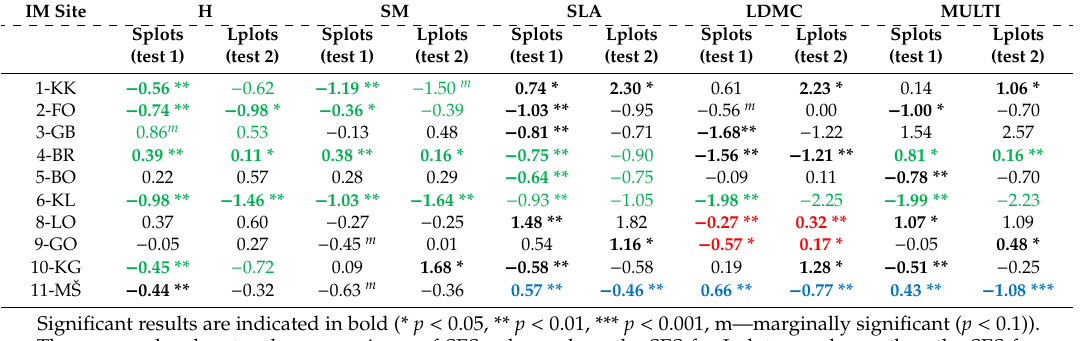
Table 5. Results of the Wilcoxon signed-rank tests for standardized e ff ect size of functional dispersion (SES FDis), separately for each IM study site and functional trait (H—height, SM—seed mass, SLA—specific leaf area, LDMC—leaf dry matter content, MULTI—all 4 traits combined). Values are the mean site-level SES FDis values. The first test (Test 1) refers to whether the values from the small plots (Splots, n = 10) are significantly di ff erent from zero. Negative values indicate trait convergence, whereas positive values indicate trait divergence. The second test (Test 2) was performed to check if the SES values from the large plots (Lplots) significantly di ff er from the SES values in Splots. IM Site H SM SLA LDMC MULTI Splots Lplots Splots Lplots Splots Lplots Splots Lplots Splots Lplots (test 1) (test 2) (test 1) (test 2) (test 1) (test 2) (test 1) (test 2) (test 1) (test 2) 1-KK − 0.56 **